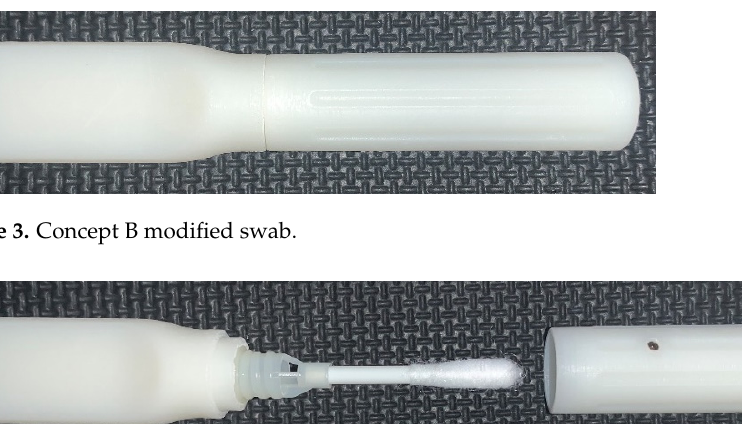
Figure 4. Concept B modified swab open.